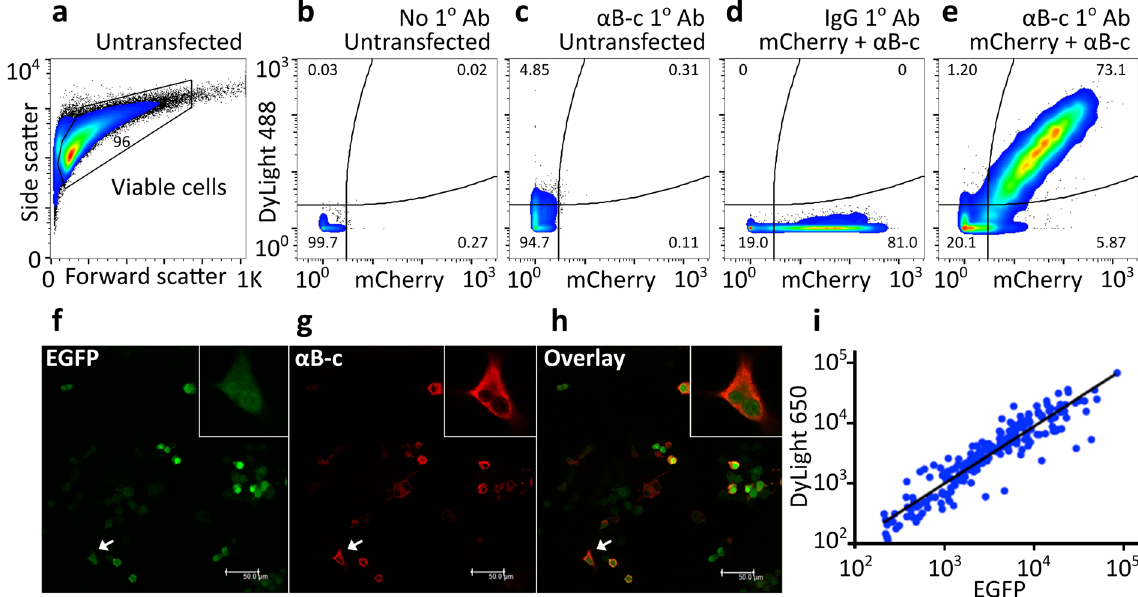
Figure 2. Validating the correlated expression of an Hsp and fluorescent reporter protein in transfected Neuro-2a cells. ( a–e ) Flow cytometric analysis of α B-c and mCherry protein expression in pIRES2-mCherry- α B-c transfected Neuro-2a cells. Data are presented as pseudo-colour plots where blue depicts – low, green – medium and red – high frequency of cells. Outliers are shown as black dots. ( a ) The untransfected sample was used to set gates for the viable cell population to exclude cellular debris and cell clumps. ( b ) Quadrant